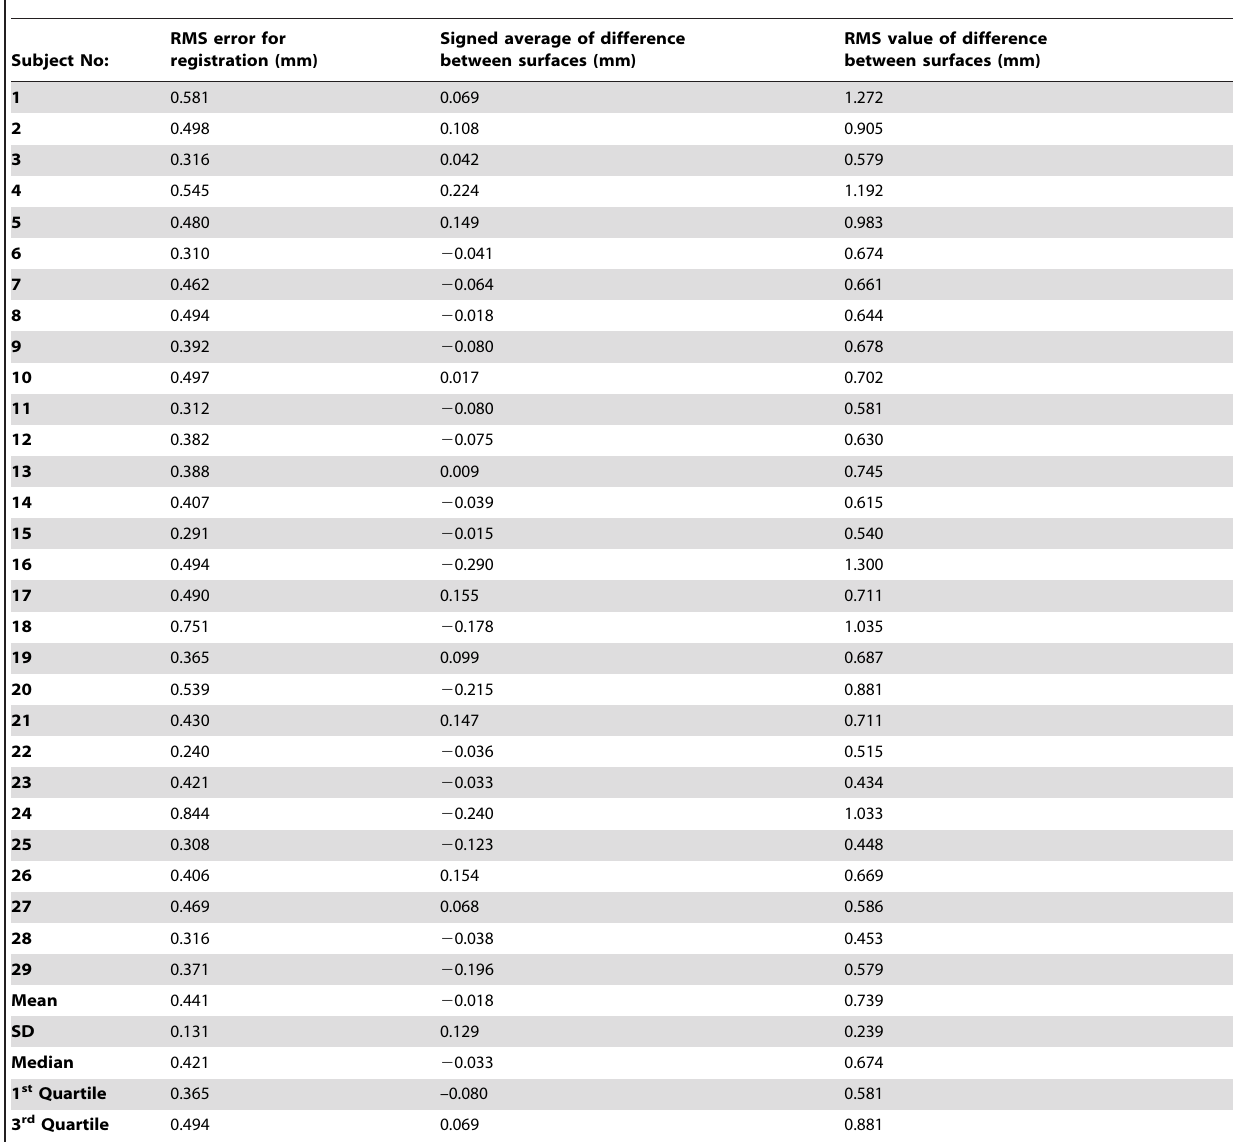
Table 1. Registration errors and distance differences between superimposed CBCT and 3-D photographic skin